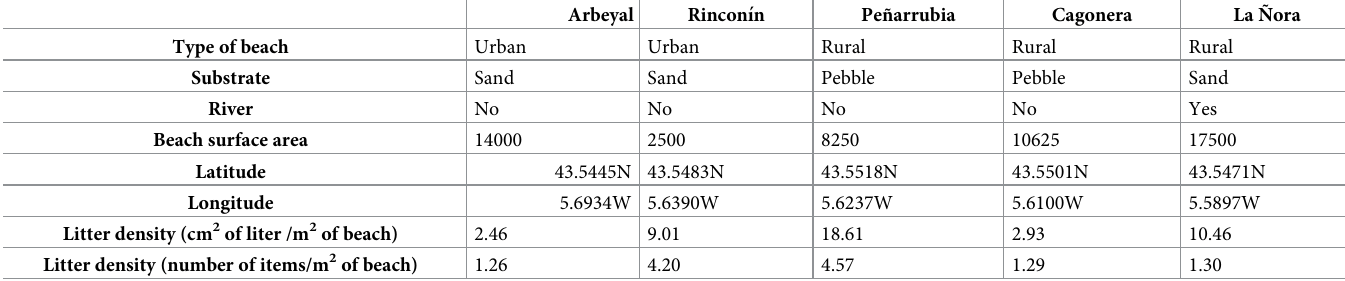
Table 1. Characteristics of the beaches sampled from the central south Bay of Biscay. Beach surface in m 2 . The litter density is given in surface as cm 2 of litter per m 2 , and as litter items per m 2